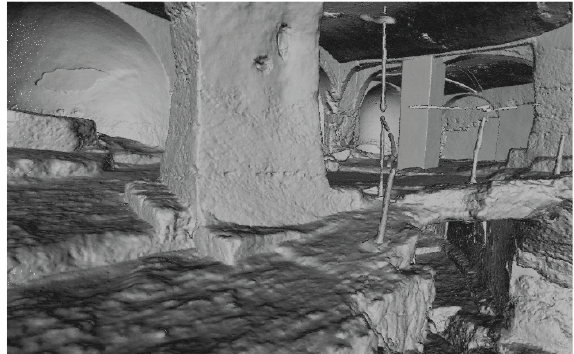
Figure 5. The global 3D model obtained after the fusion phase of single shots (complexity of 50 M triangles, model density about 1 point per 5 mm).